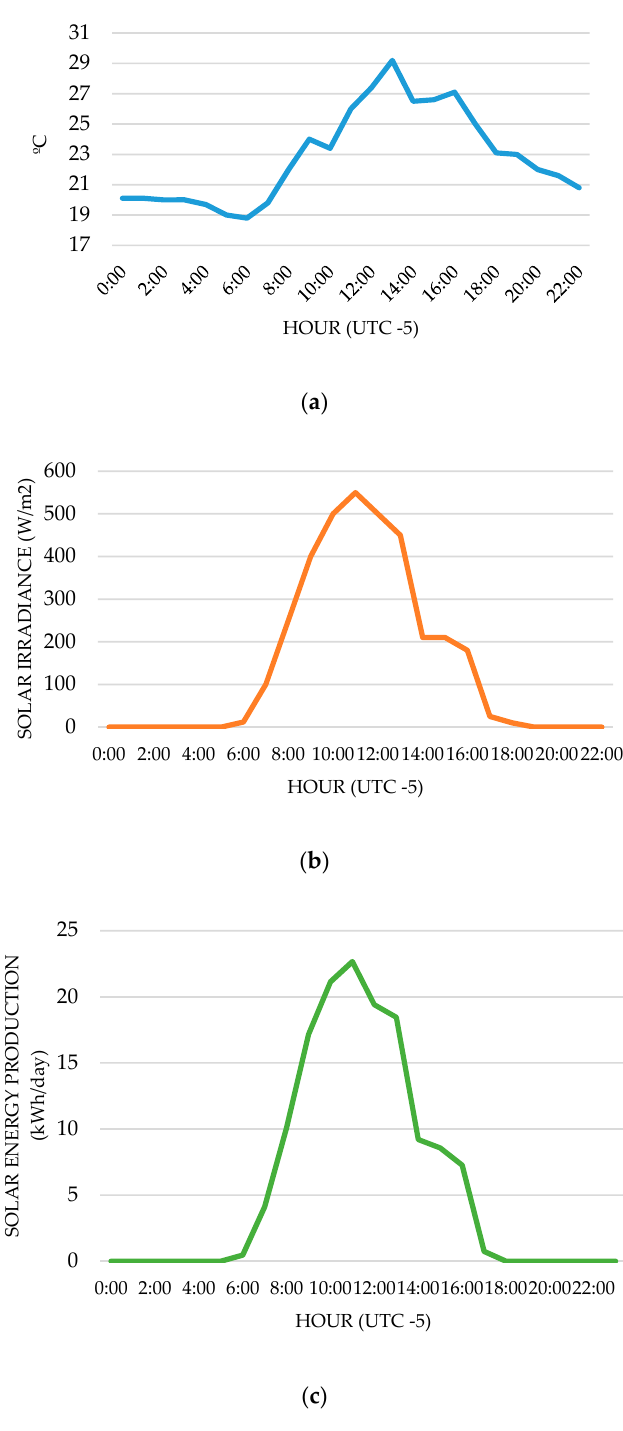
17 of 24 Figure 10. ( a ) Ambient temperature, ( b ) solar irradiance and ( c ) energy produced by the PV system on October 22nd (time in hours corresponding to UTC-5).